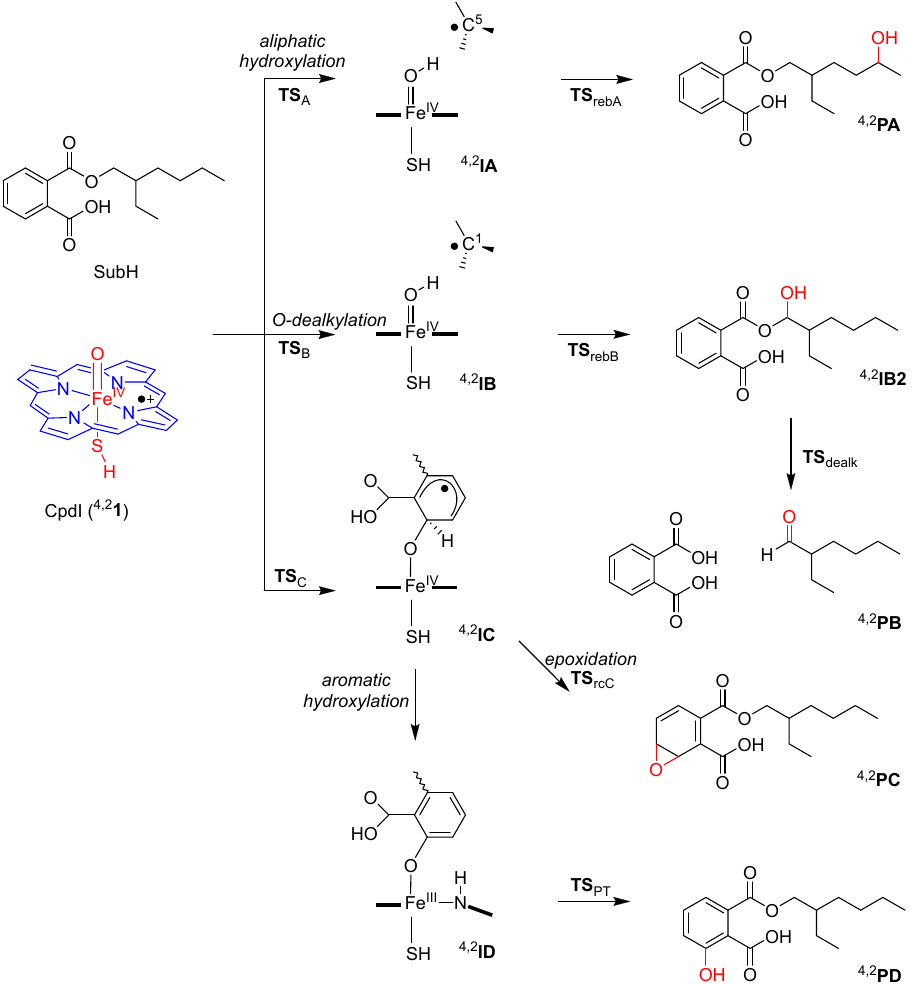
Figure 3. P450 model and reaction mechanisms (with nomenclature) studied in this work.